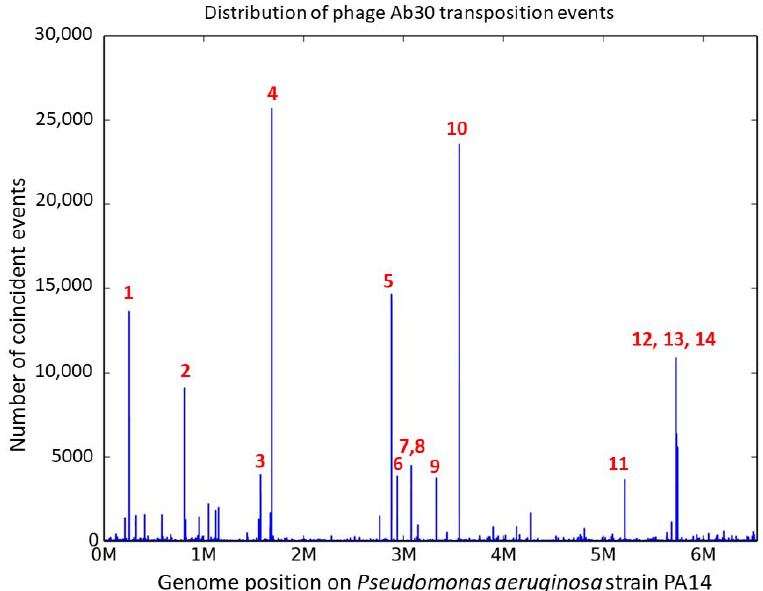
Figure 2. The phage Ab30 major transposition hotspots. The distribution of the 13 million Ab30 transposition events is plotted along the PA14 bacterial host genome at a one base-pair resolution. On the vertical axis, the number of transposition events at a particular position is shown. The 14 sites with at least one position hosting more than three thousand insertions are numbered.